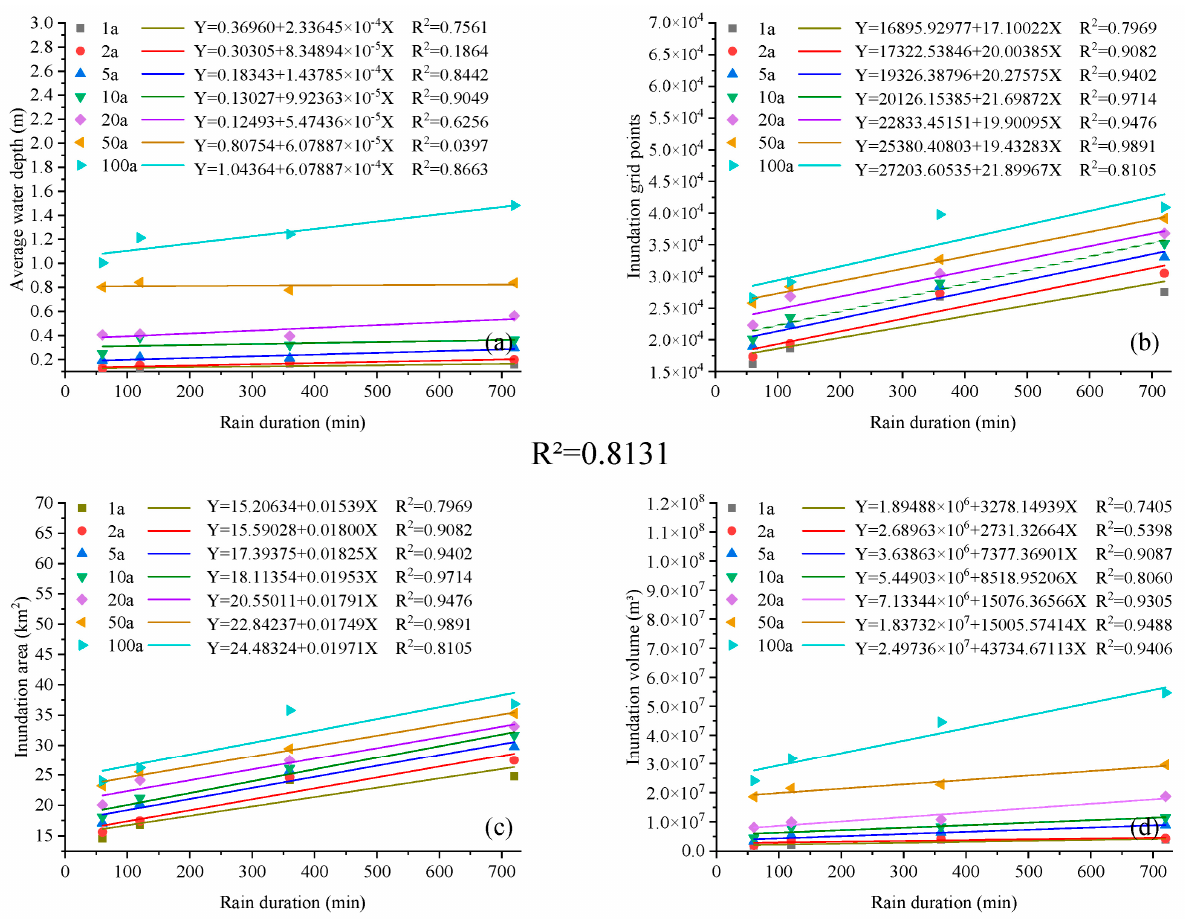
Figure 15. Trend chart of relationship between submerged water depth( a ), submerged grid points ( b ), submerged area ( c ), submerged water volume ( d ) and rain duration. (The rain duration and the four submergence indicators are linearly correlated, with an average R 2 of